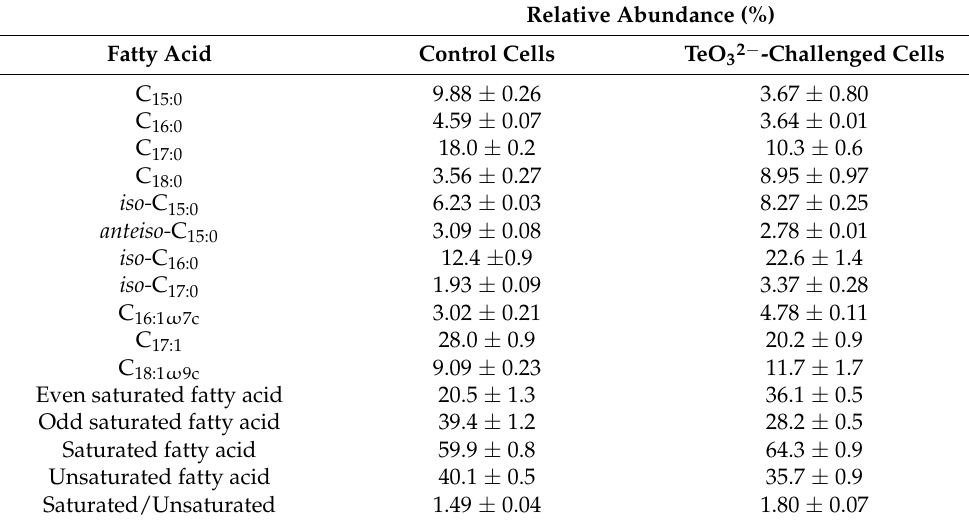
Table 1. The relative percentage of total fatty acids isolated from Micromonospora cells exposed for 6-h to TeO 32 −